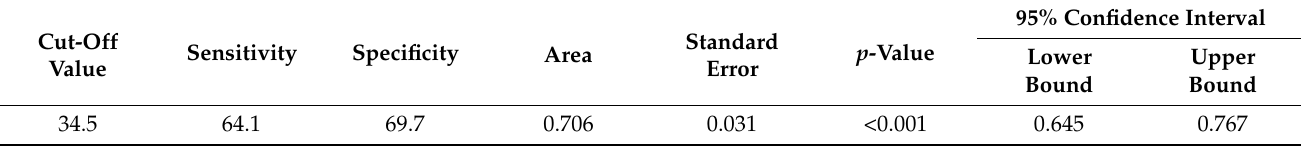
Table 6. Test Result Variable(s): vitamin